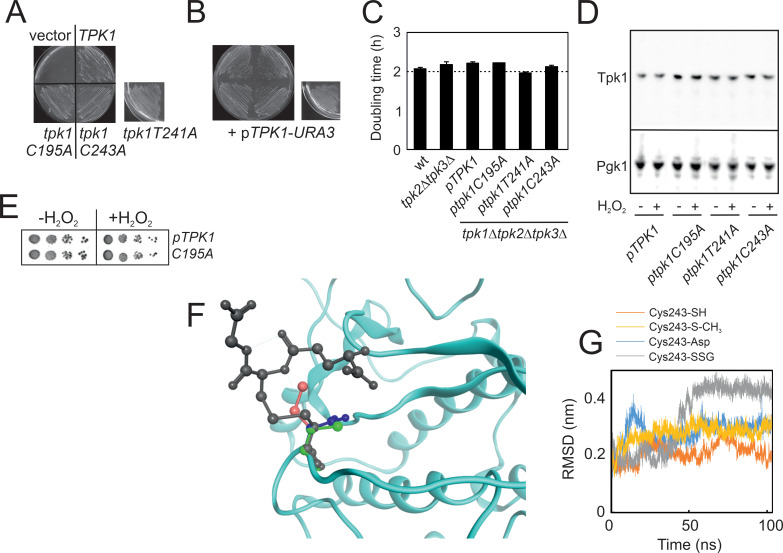
Substitution of Cys195, Thr241 and Cys243 by alanine in the yeast.PKA catalytic subunit Tpk1 neither affects viability nor growth, whereas in silico simulation suggest that glutathionylation, but not sulfenylation, of Tpk1Cys243 significantly impacts on Tpk1 structure.(A) Growth of tpk1Δtpk2Δtpk3Δ cells transformed with the vector (vector) or the indicated pRS313-TPK1 plasmids and pRS316-TPK1 (pTPK1-URA3) on solid synthetic defined (-HIS, 5-FOA) medium to counterselect pTPK1-URA3. (B) Growth of the strains in (A) on solid synthetic defined selective (-HIS, URA) medium. Cells in A) and B) were left to grow for 3 days before photographed. (C) Doubling time of the indicated tpk-mutant strains in synthetic defined -HIS medium. (D) Tpk1 levels are not significantly altered in Tpk1 substitution mutants neither with nor without H2O2 (0.4 mM. 10 min). Pgk1 levels were used to indicate protein loading. (E) H2O2 resistance of TPK1 tpk2Δ tpk3Δ and tpk1C195A tpk2Δ tpk3Δ-mutants as indicated. (F) Alignment of cysteine (green), aspartate (blue), methylthiolated (pink) or glutathionylated cysteine (grey) in position 243 in the Tpk1 homology model. (G) Root-mean-square deviation of the C-alpha distances in C243-SH (orange), Cys243Asp (blue), Cys243 methylthiolated (yellow) and C243 glutathionylated enzyme (Cys243-SSG, grey) upon molecular dynamic simulation.